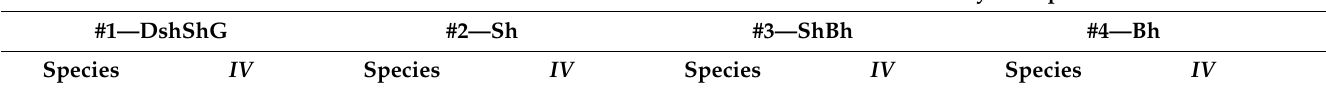
Table A3. Cont. Community Group